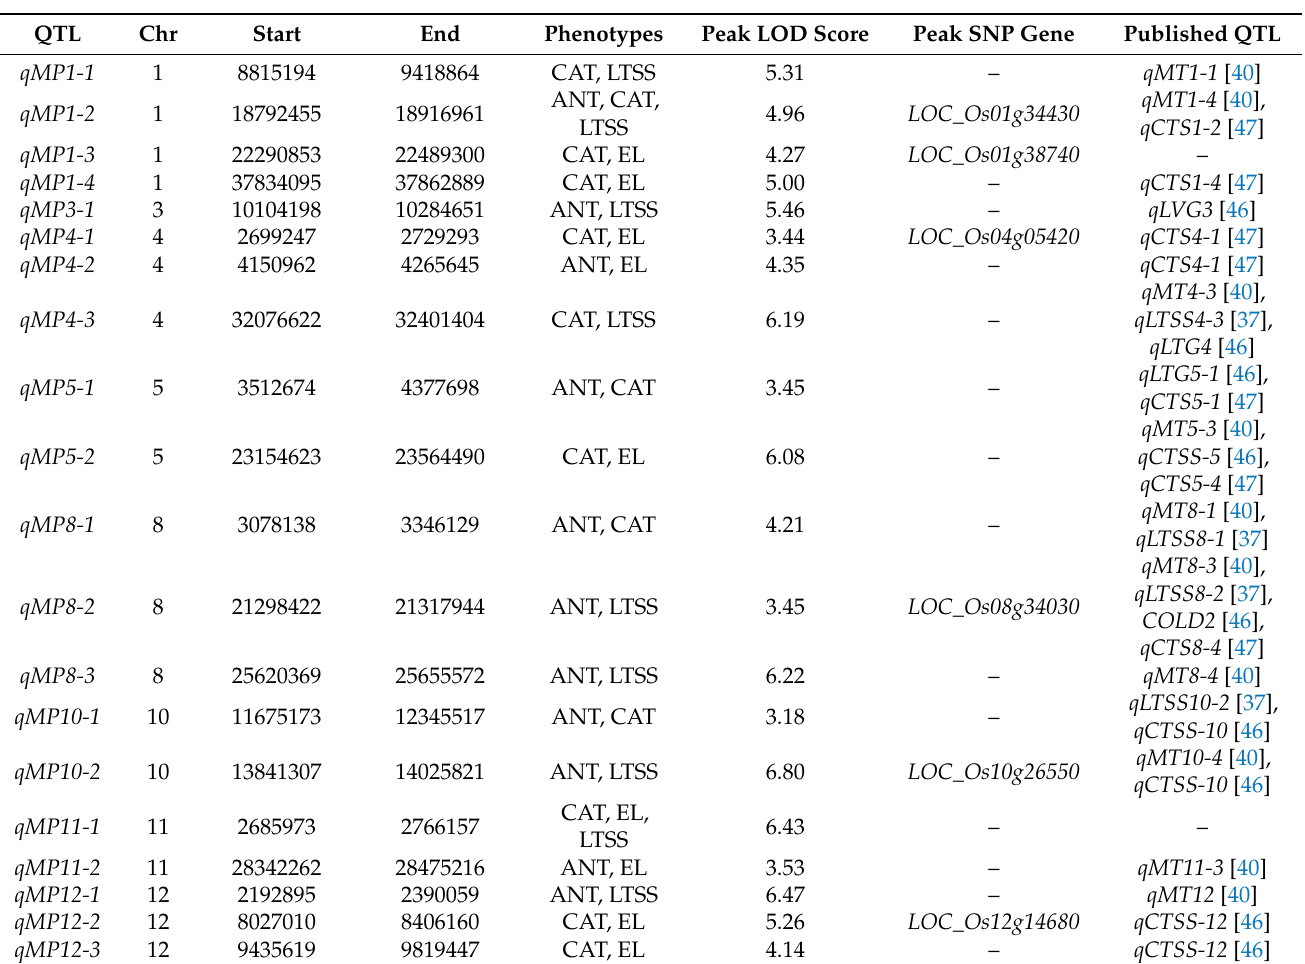
Table 2. Summary of 20 Multiple-Phenotype ( MP ) QTL identified by GWAS mapping for four phenotyping assays of 370 RDP1 O. sativa accessions after a 7-day-10 ◦ C chilling treatment. LTSS: Low Temperature Seedling Survivability; EL: Electrolyte Leakage; CAT: Catalase Activity; ANT: Anthocyanin Activity; LOD: Logarithm of the Odds; SNP: Single Nucleotide Polymorphism. See Supplementary Table S3 for details on published